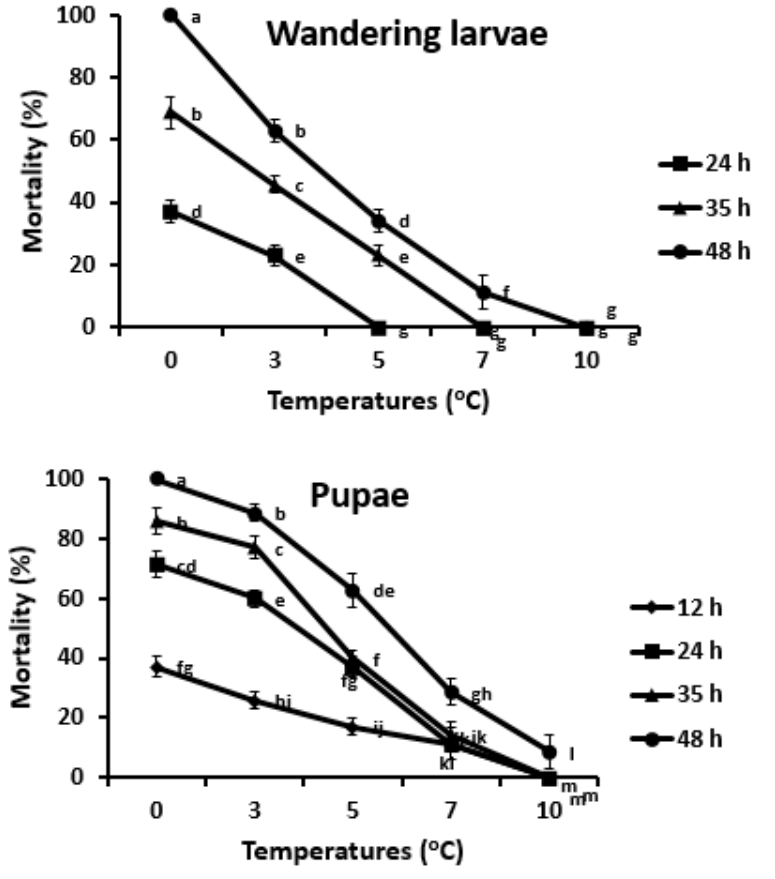
Figure 1. Percent mortality of feeding larvae, wandering larvae and pupae of SHB at different temperatures with lethal hours only (with respective to each stage). Table 3. Lethal temperature to kill 50% and 80% population (LT 50 & LT 80 ) of each SHB stage at lethal hours (0–100% mortality).